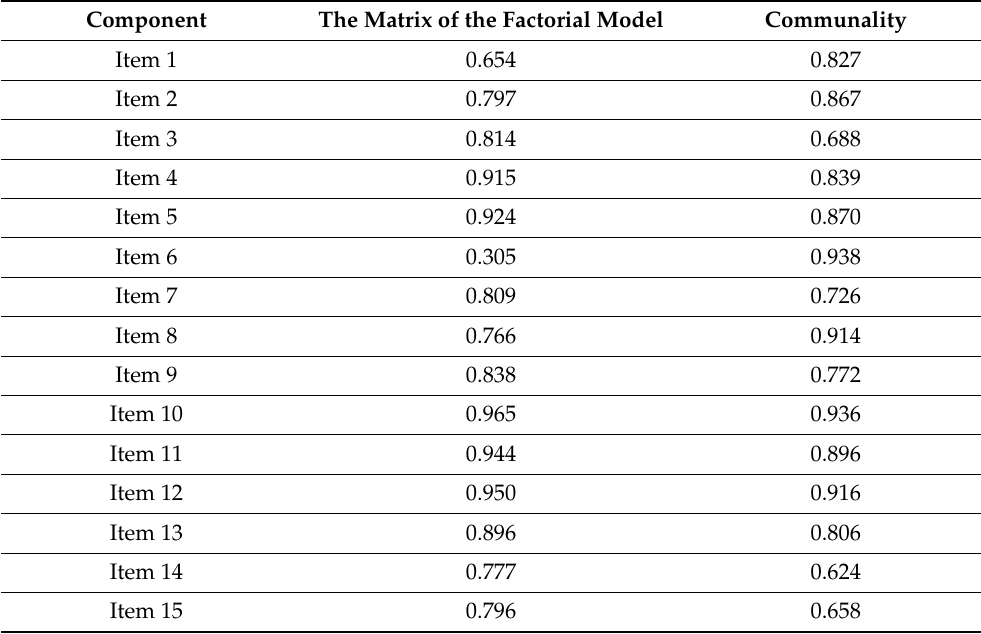
Table 5. Matrix of the factorial model at the MPIS.